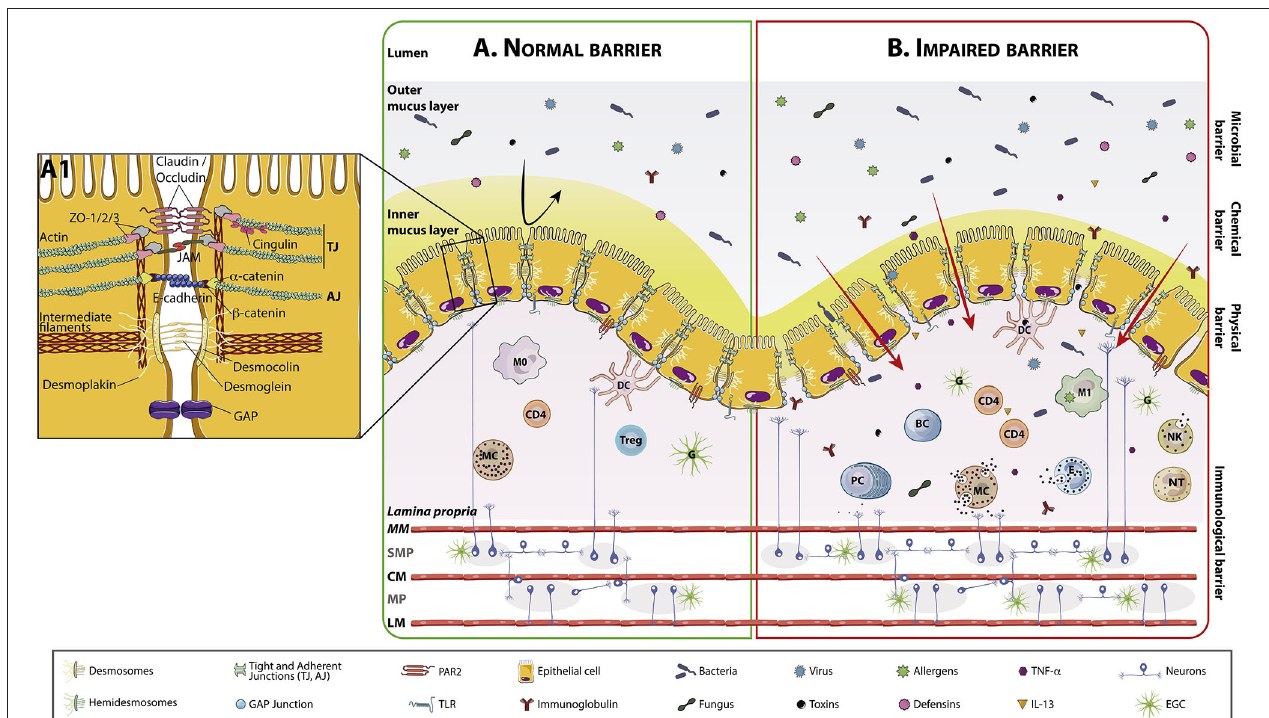
FIGURE 1 | Intestinal barrier anatomy and its components in normal and impaired conditions. The intestinal mucosa comprises a layer of polarized, columnar epithelial cells next to a subepithelial region that contains the lamina propria , the enteric nervous system, connective tissue, and muscular layers. On top of columnar cells there is the mucus layer. Normal mucus is 98% water, being the rest glycosilated proteins (mucins) and glycolipids. In the colon, mucus has an outer layer, densely colonized by bacteria, fungus, virus, and able to retain toxins and allergens, and a mostly sterile inner layer where immunoglobulins (mostly secretory-IgA), and defensins such as lysozyme are present. The inner mucus layer is dense and attached an ∼ 50 µ m thick and the outer layer is loose and unattached and about 100 µ m thick. The small intestine has only one single mucus layer, which is much thinner than the mucus layer in the large intestine. The lamina propria includes a diffuse lymphoid tissue constituted by macrophages, dendritic cells, plasma cells, lamina propria lymphocytes, MCs, eosinophils and occasionally, neutrophils. (A) The intestinal barrier in homeostasis, where cells are closely attached by intercellular junctions (TJs, adherens junctions, desmosomes and GAP junctions) represented in detail in (A1). (B) Impaired intestinal barrier, with increased trans and paracellular passage of lumen contents. This increased transport activates the immune system and cell recruitment and degranulation in the lamina propria . MC and PC are able to modulate the ENS interacting with SMP/MP neurons and with EGCs. (A1) Representation of intercellular junctions. Intercellular junctions are primary responsible for nutrient absorption and water and chloride secretion. Intercellular junctional complexes, including TJs, adherens junctions, gap junctions, and desmosomes, are dynamic structures that restrict the passage of molecules: 4–5 Å at the villus tip to over 20 Å at the base of the crypt in the small bowel. The integrity and structure of epithelial cells are mostly modulated by the cytoskeleton, mainly by actin, myosin, and intermediate filaments. Cells adhere to the basement membrane through hemidesmosomes. TJs are primarily made up of CLDNs, OCLNs, and JAM proteins, which are connected through zonula occludens and cingulin to the cytoskeleton. Adherens junctions include cadherins such as E-cadherin, which binds catenins ( α and β ) connected to the cytoskeleton. Desmosomes are mainly comprised of desmocollin and desmoglein, which interact with desmoplakin, in turn connected to the intermediate filaments. AJ, Adherens junctions; BC, B Cell; CD4, Lymphocyte T helper CD4 + ; CLDN, Claudin; CM, Circular muscle; D, Desmosomes; DC, Dendritic cell; EGC, Enteric glial cell; ENS, Enteric nervous system; IL-13, Interleukin 13; JAM, Junctional adhesion molecule; LM,